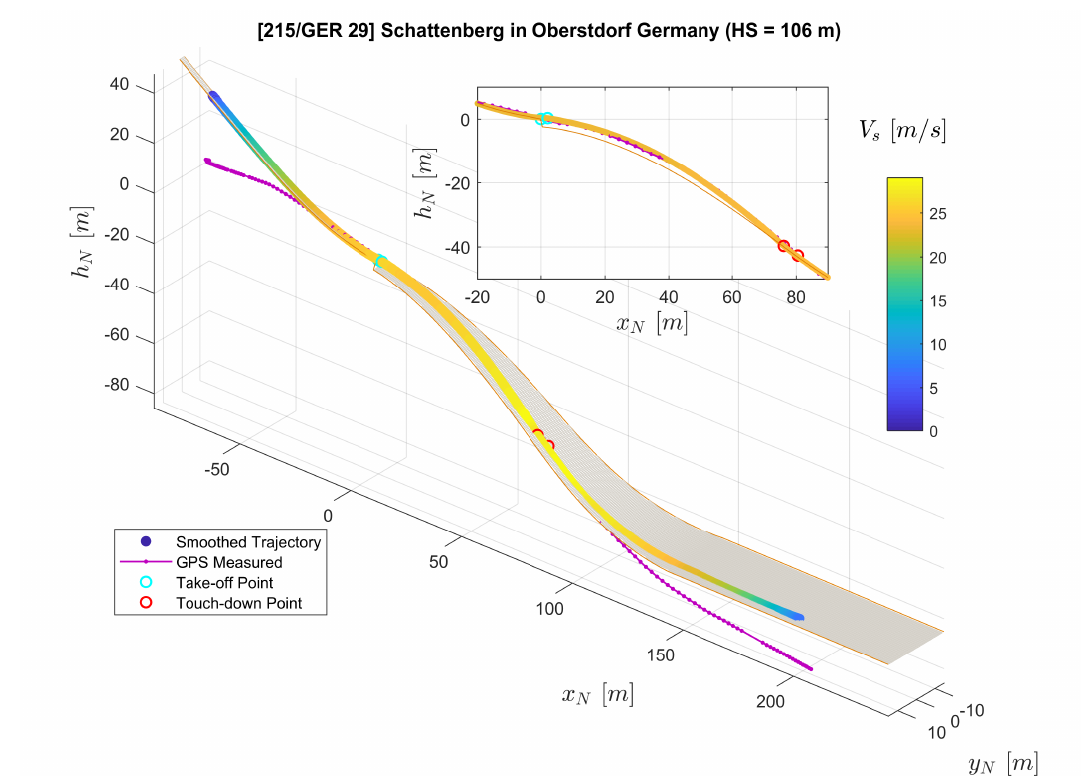
Figure 18. Trajectory Reconstruction result for Jump No. 5.